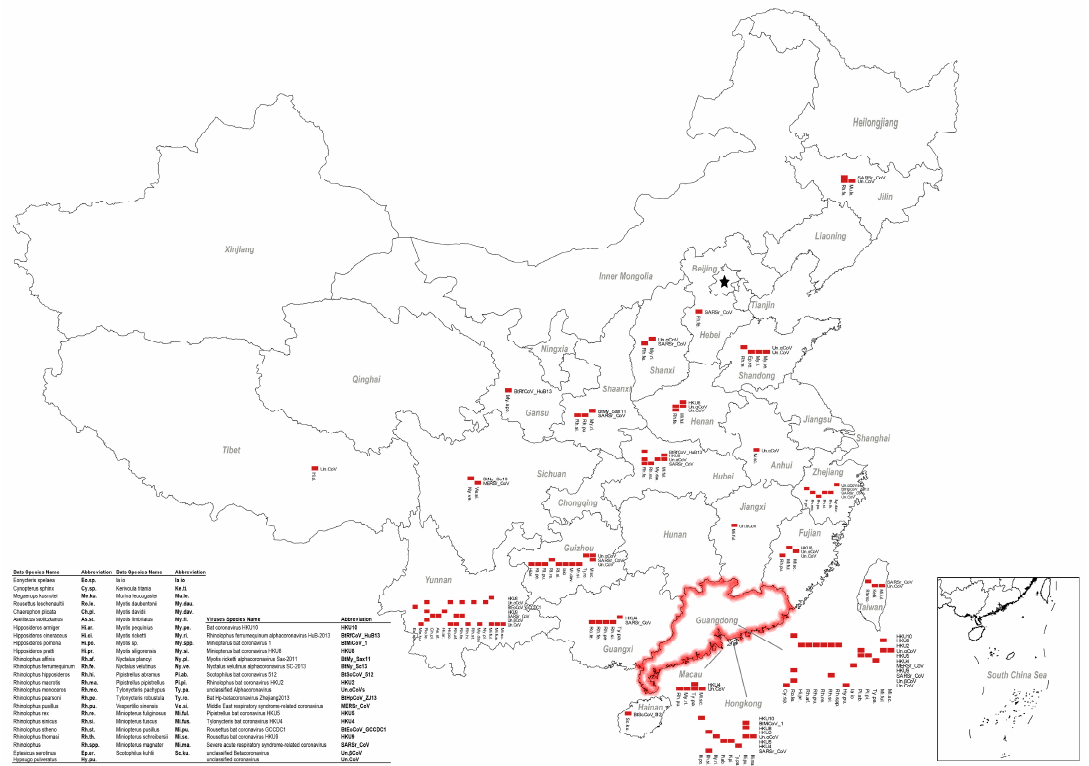
Figure 1. Geographical distribution of bat coronaviruses (CoVs) and their corresponding bat hosts in China. Each red box represents one CoV positive sample found in that particular bat species. One dot matrix was drawn for each province where a CoV positive sample had been reported. Guangdong Province, where SARS and SADS began, is circled in red. Abbreviations of bat species and virus species are indicated.